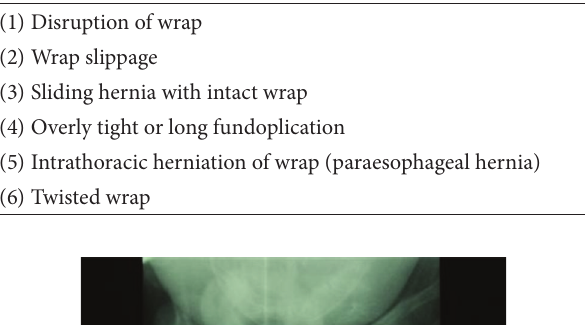
Table 6: Common causes of fundoplication failure described by Hunter et al. [16].